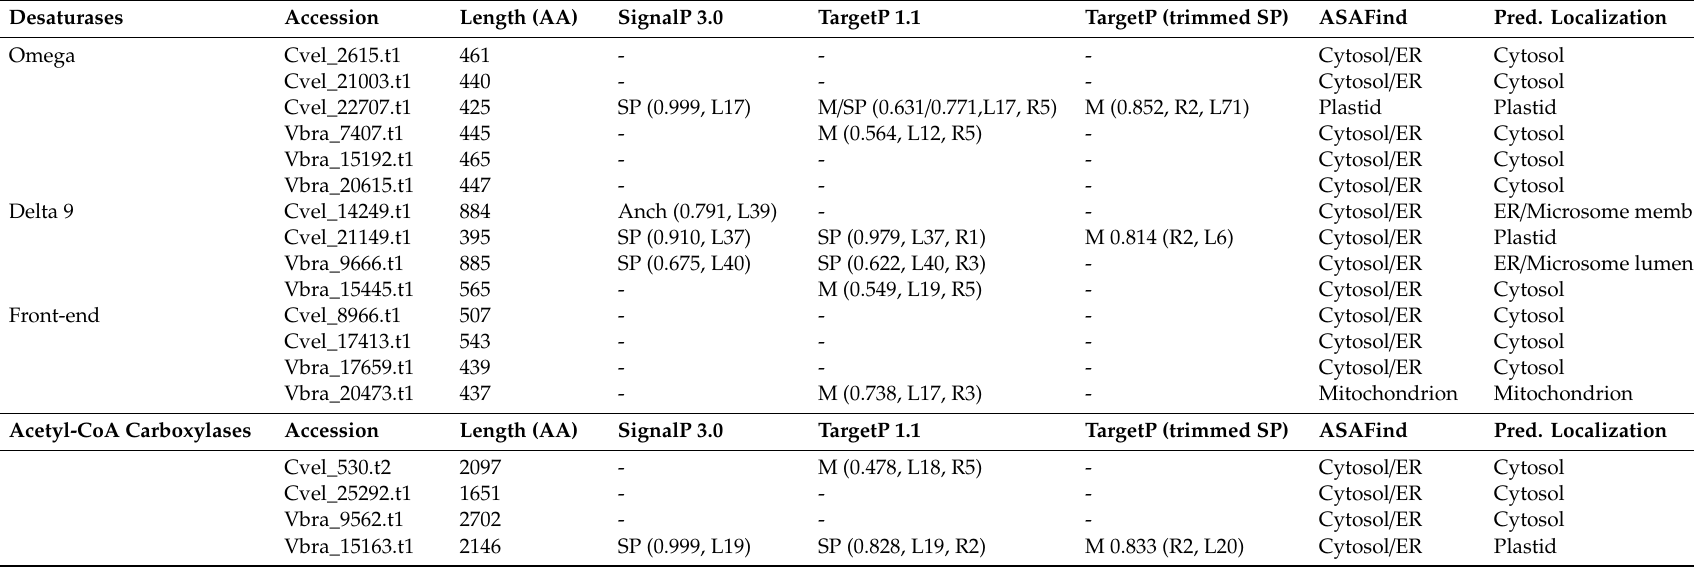
Table 5. Ketoacyl synthases, elongases, and desaturases in chromerids and their predicted subcellular